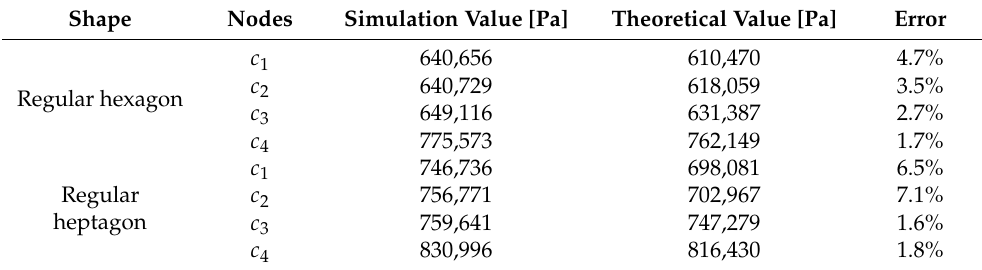
Figure 6. Finite element simulation stress distribution. Table 1. Comparison of the simulation and theoretical values of both membranes.